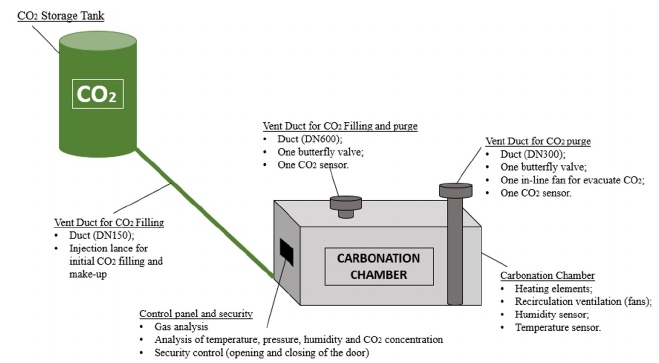
Figure 13. Chamber and CO 2 supply facilities, equipment, and sensors for carrying out CO 2 curing in the industry. Source: Author